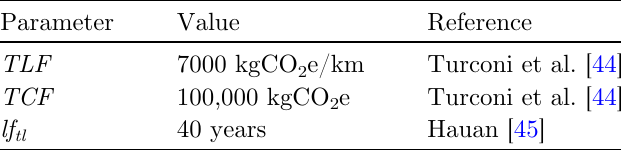
Table 4. Transmission line emission parameters.